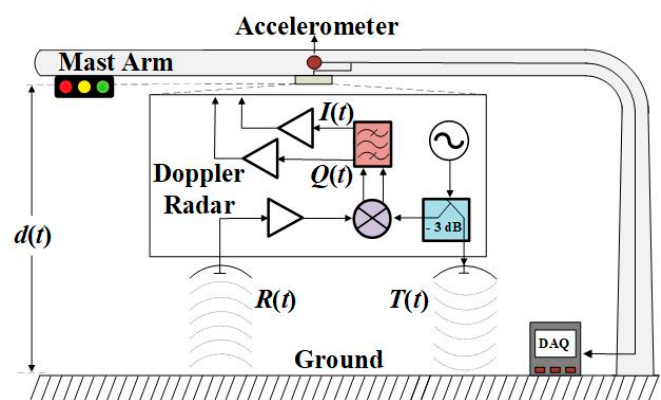
Figure 6. Block diagram for field structural health monitoring based on Doppler radar. Reprinted with permission from ref. [70]. Copyright 2020 IEEE.